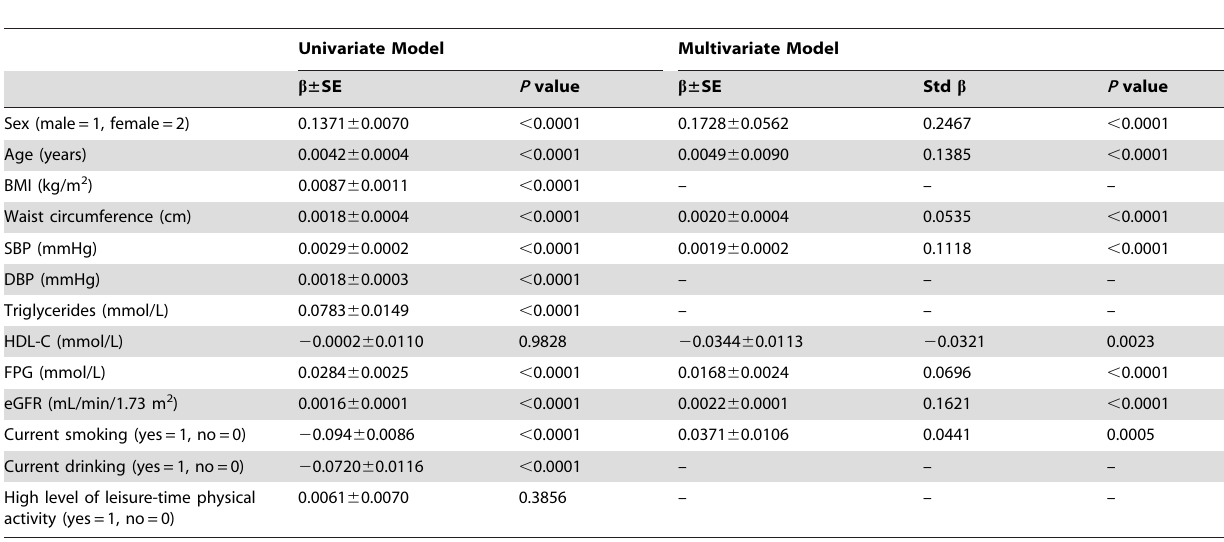
Table 2. Simple and multiple stepwise linear regression analysis of metabolic risk factors associated with